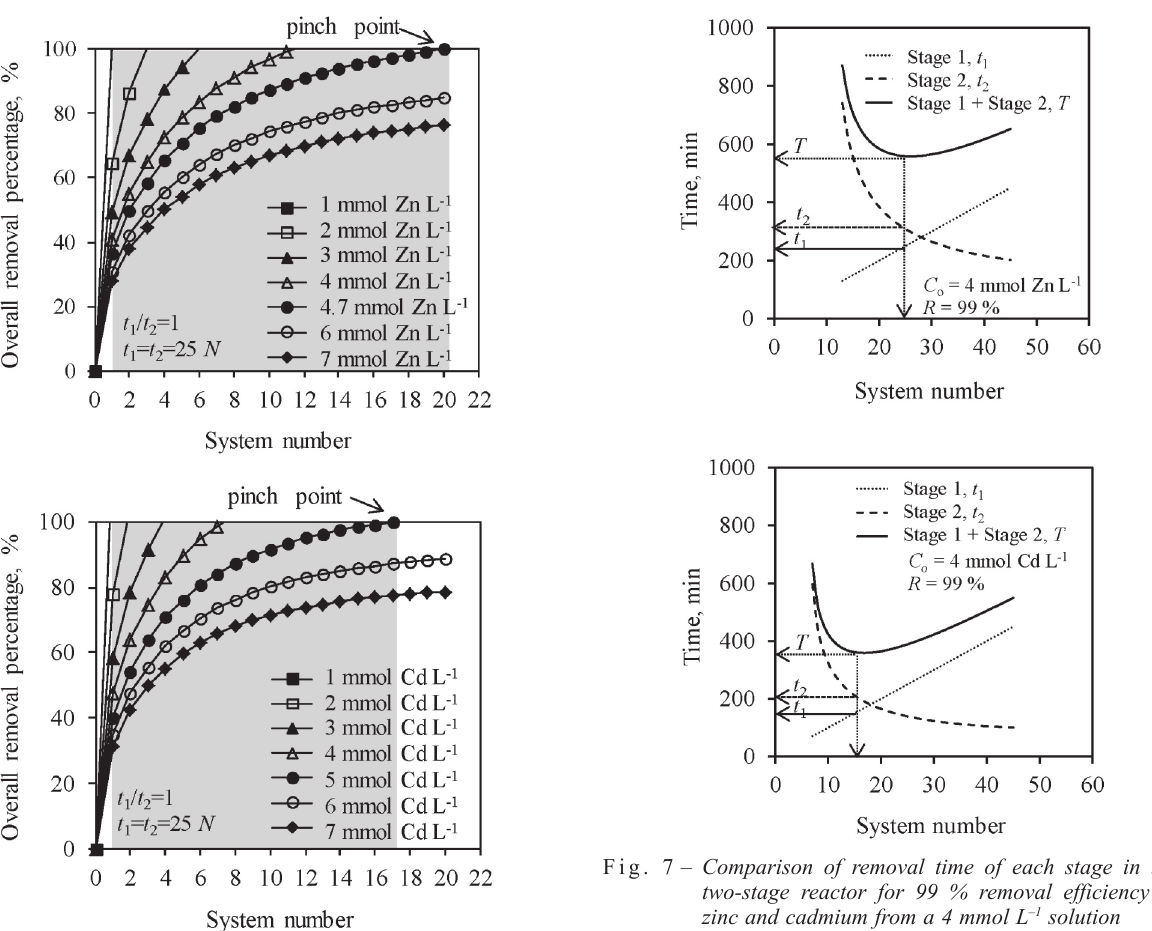
Fig. 7 – Comparison of removal time of each stage in the two-stage reactor for 99 % removal efficiency of zinc and cadmium from a 4 mmol L –1